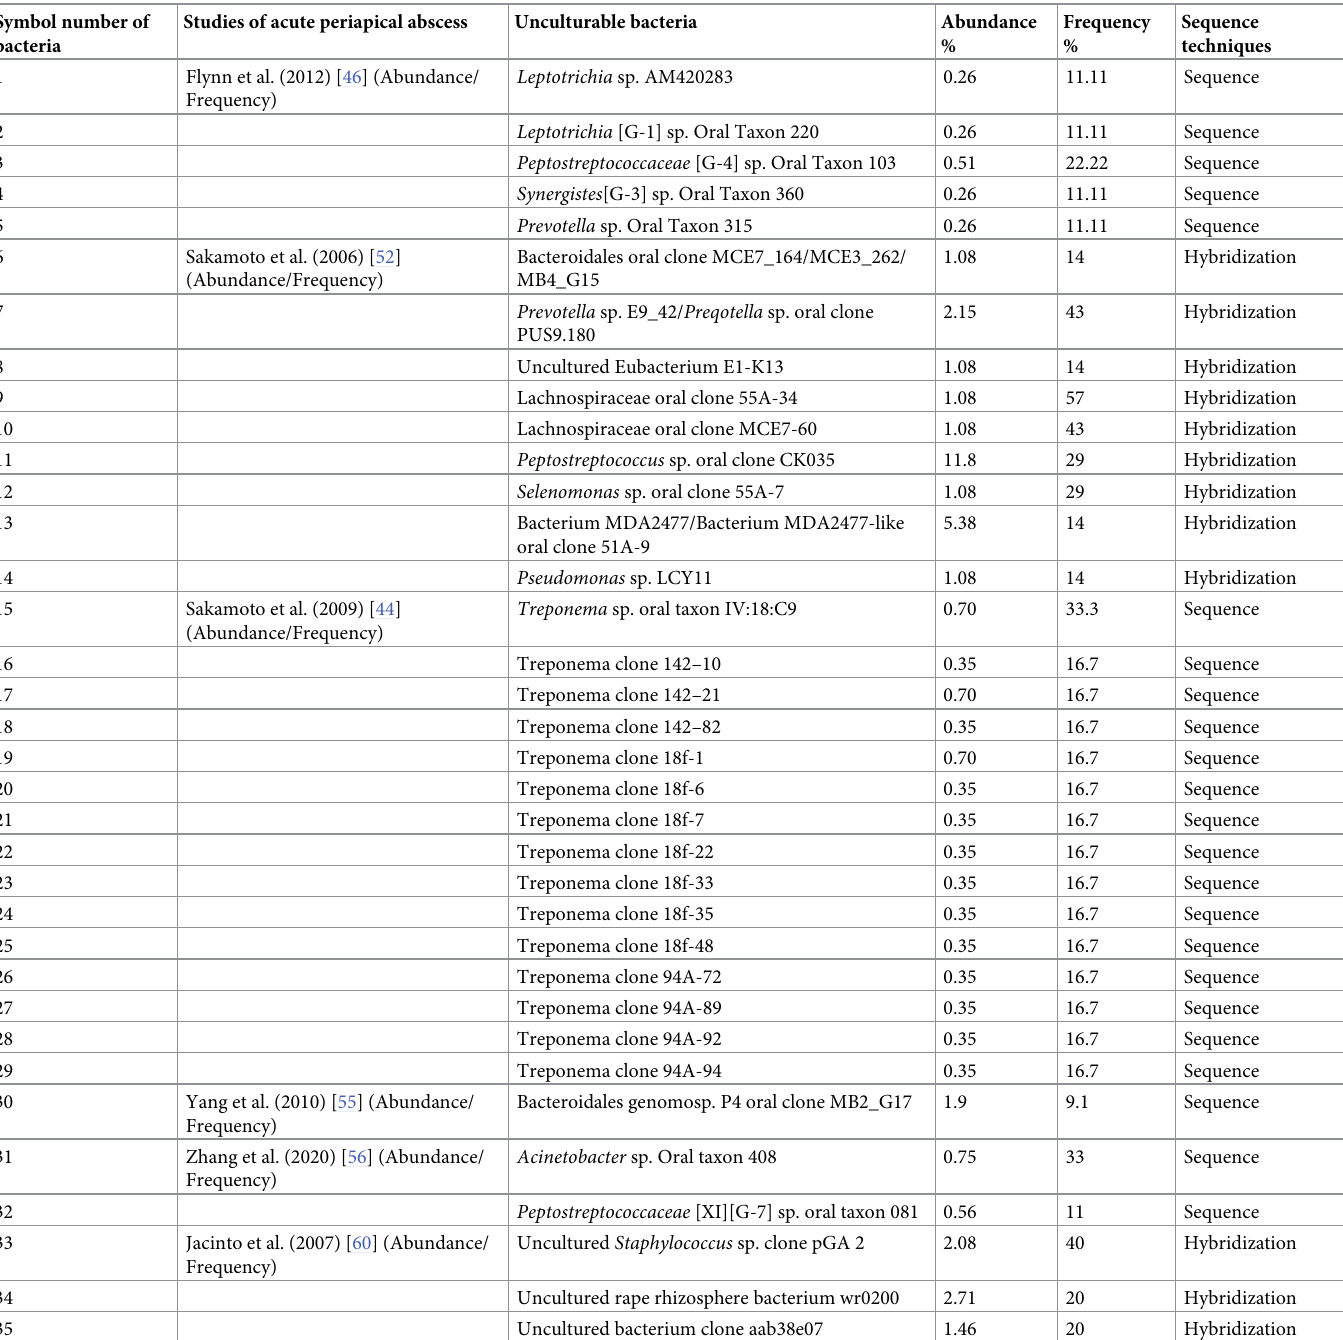
Table 3. Secondary outcome measures of individual unculturable bacteria with active abundance and frequency, and supplementary sequence technique variables. Symbol number of